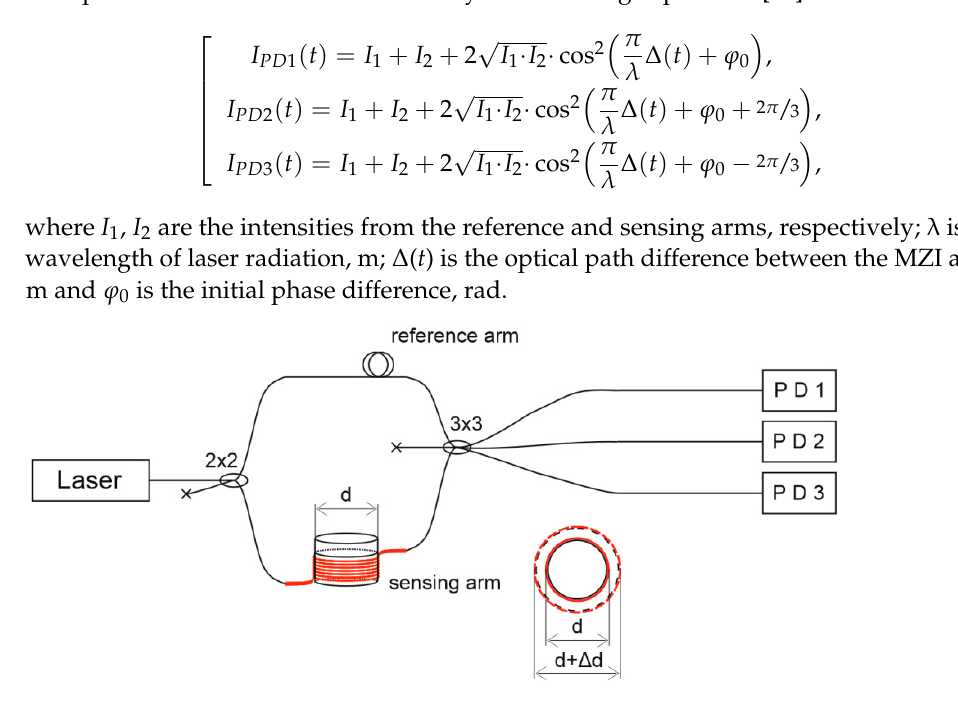
Figure 1. Scheme for the deformation measurement using an MZI.